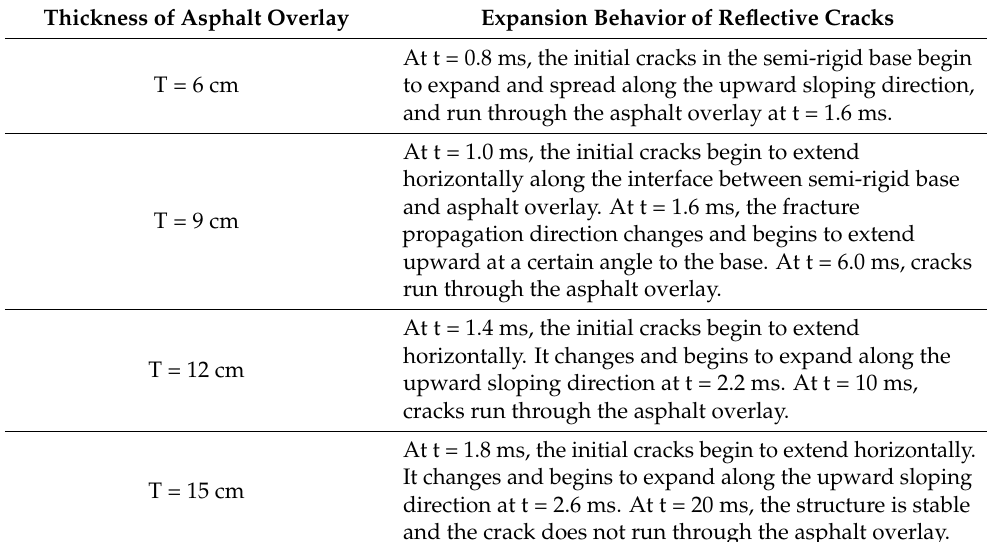
Table 4. Expansion behavior of reflective cracks in asphalt overlays of different thicknesses. Thickness of Asphalt Overlay Expansion Behavior of Reflective